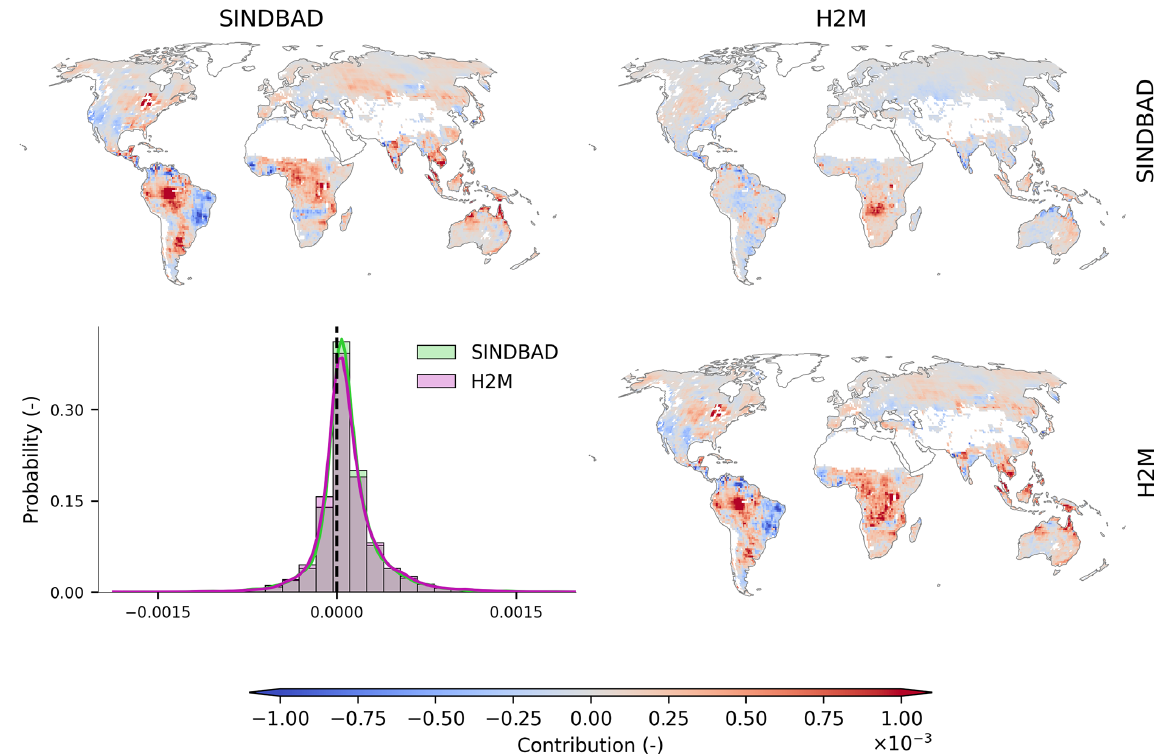
Figure 4. Global distribution of pixel-wise contributions to the variance in the modeling error in the global terrestrial water storage interannual variability. Along the diagonal, maps of the pixel-wise contribution to the global TWS IAV modeling errors in SINDBAD and H2M are shown. Above the diagonal, a map of the difference (i.e., H2M − SINDBAD) is shown. Below the diagonal, a histogram comparing the corresponding column ( x axis) versus row ( y axis) is shown. The probability density curves were estimated using the Gaussian kernel and Scott’s rule of thumb to determine the bandwidth of the kernel. White pixels within land boundaries are the regions masked out in this study (see Appendix A).